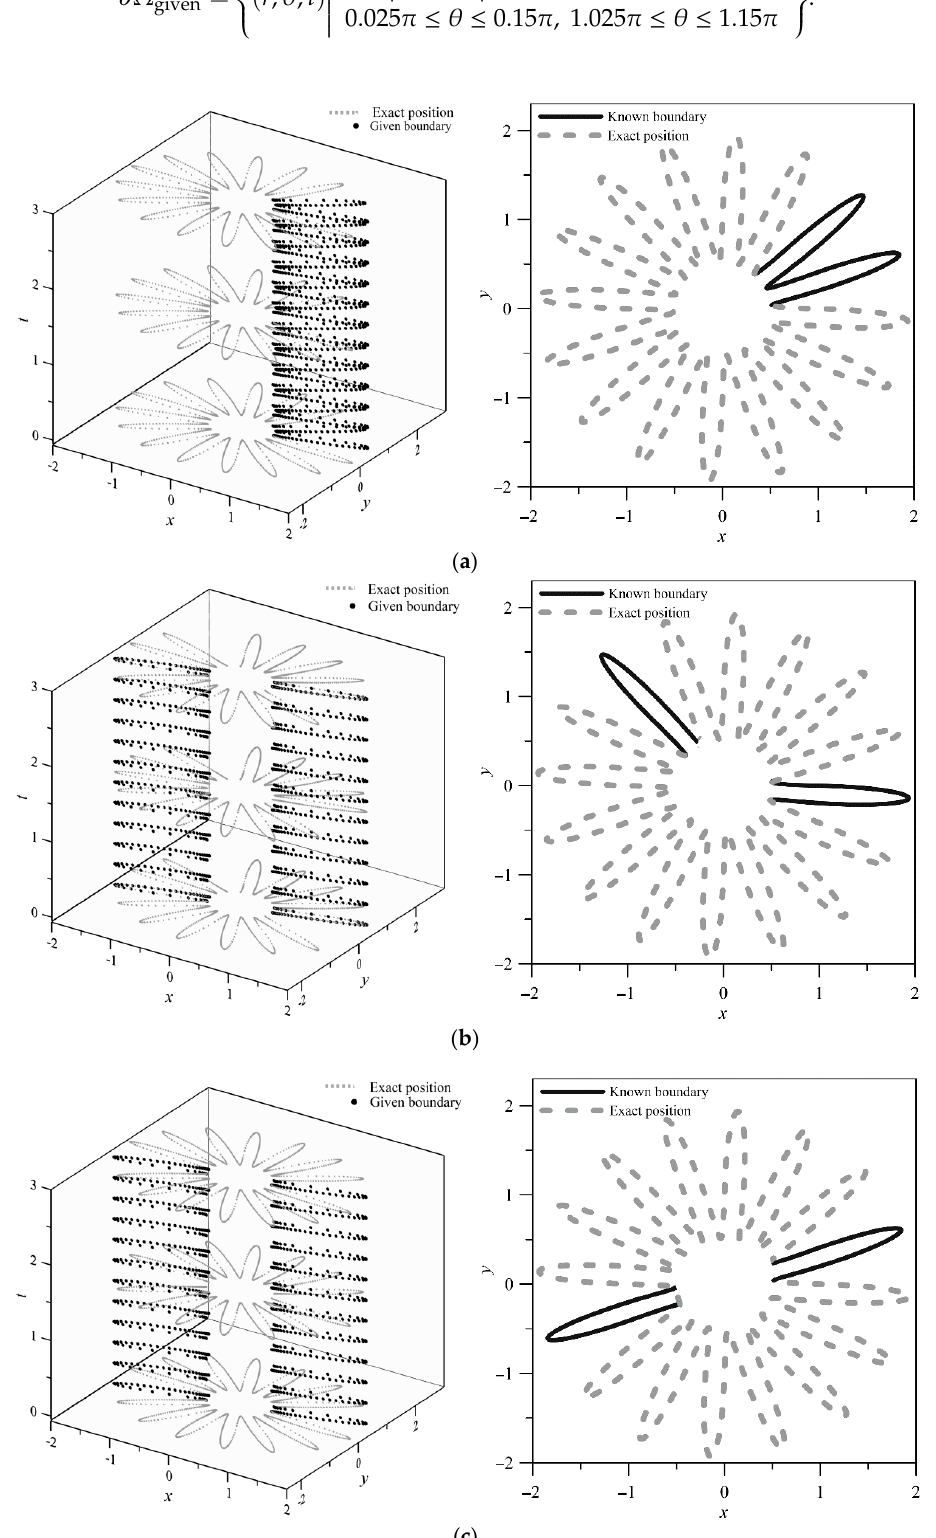
Figure 9. The collocation scheme: ( a ) case 1; ( b ) case 2; ( c ) case 3. From Equations (37)–(39), it is found that the accessible boundary data are only assigned at 1/8 portion of the space–time boundary.